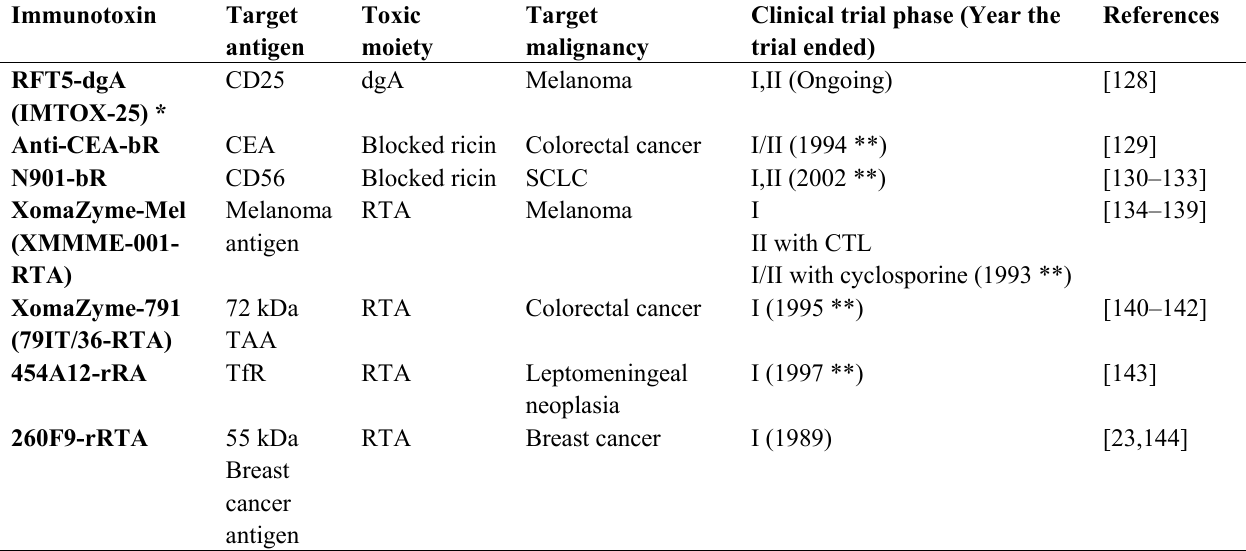
Table 4. Clinically evaluated/under evaluation RT-based immunotoxins against solid tumors.